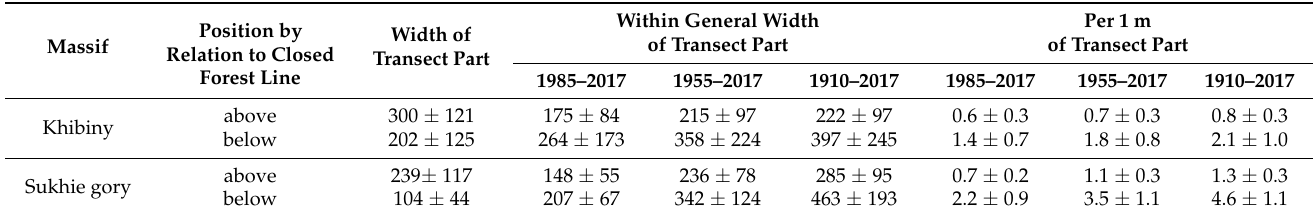
Table 5. Increment of aboveground stand biomass (ton on each km of length) (mean ± SD) above and below the contemporary closed forest line on the slopes of the Khibiny massif (Kola Peninsula) and Sukhie Gory (Putorana Plateau) between 1910 and 2017.